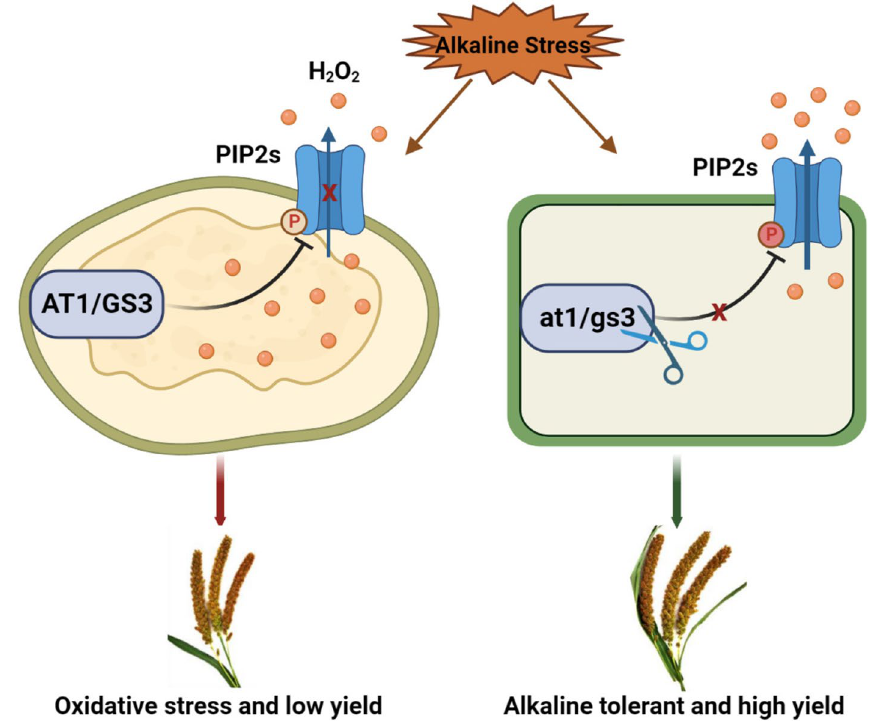
Fig. 1 A proposed model of the Gγ subunit AT1/GS3-mediated alkaline stress responses in plants Oxidative stress occurs when plant cells are subjected to alkaline stress, and H2O2 produced which is toxic to cells, resulting in the failure of plants to complete the normal life cycle. The Gγ subunit AT1/GS3 inhibits the phosphorylation of aquaporin proteins PIP2s on the plasma membrane, resulting in excessive harmful H2O2 that cannot be pumped out of the cell timely and effectively, harming the growth and development of crops and resulting in low yield. Modification of AT1/GS3 can alleviate this toxicity, endow plants with high alkaline tolerance, and significantly increase